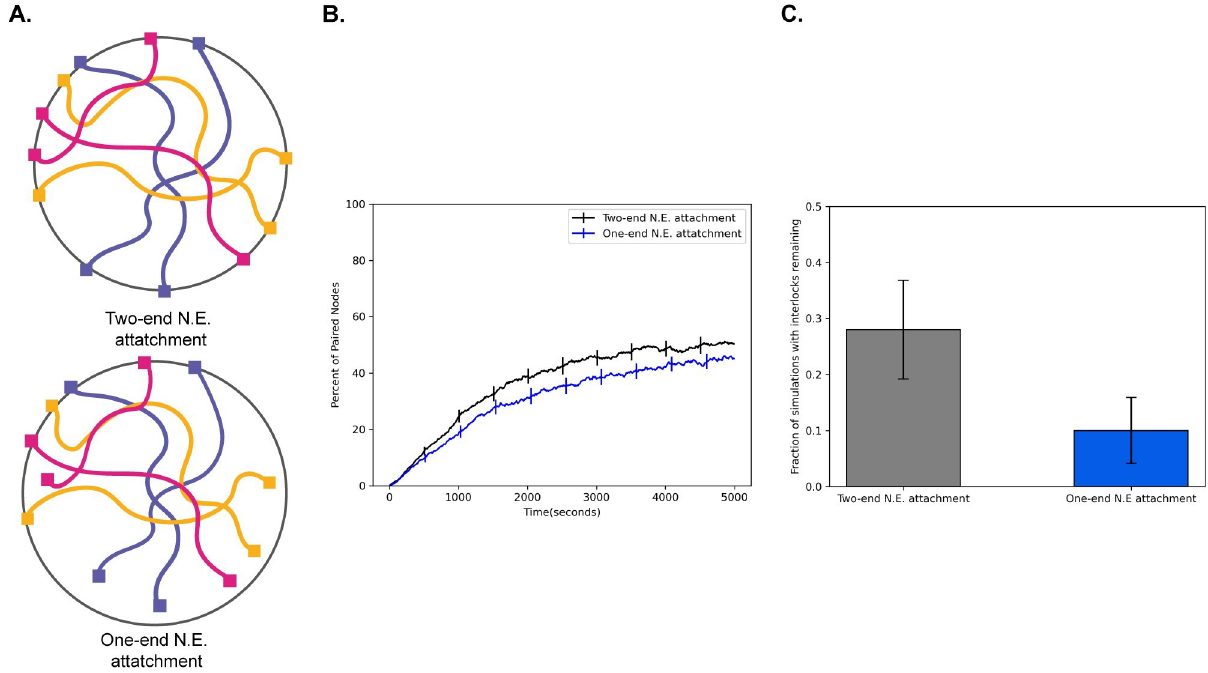
Fig 7. Single-end attachment facilitates interlock resolution. (A) Cartoon schematic of double end vs. single end chromosome attachment to the NE (B) Percent of paired nodes vs. time for single end vs. double end chromosome attachment shows an increase in pairing speed with both ends attached. (C) Percent of simulations with interlocks remaining for single end vs double end chromosome attachment shows a greater number of cells with interlocks remaining in the case where both ends are attached to the N.E. Error bars indicate 95% confidence intervals.